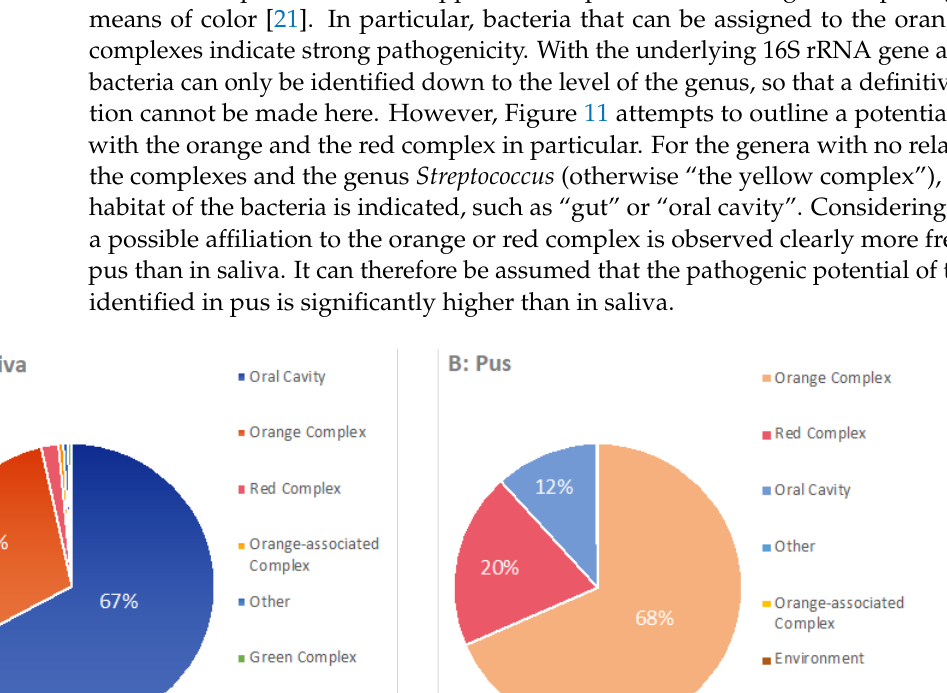
Figure 10. Median metabolism of the saliva samples ( A ) and the pus samples ( B ) ( n = 50). There is a clear increase in the proportion of anaerobic bacteria in the abscess.